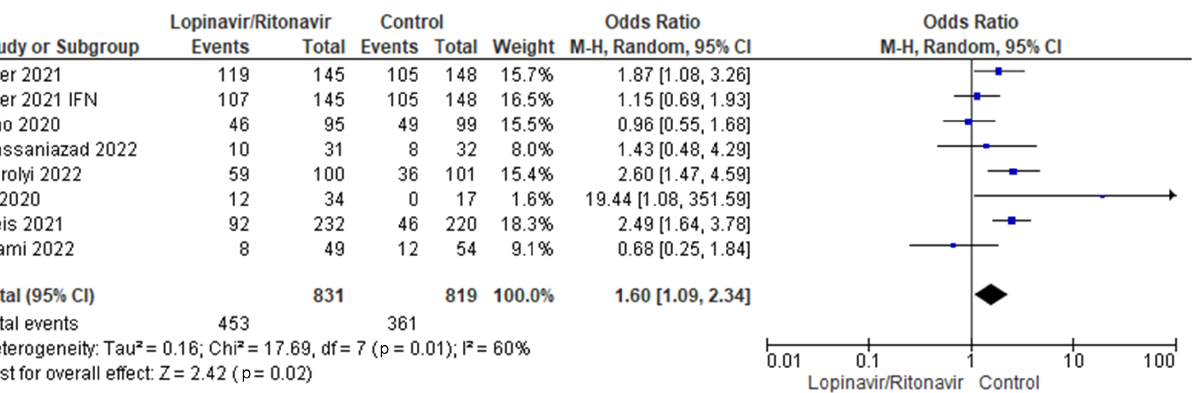
Figure 5. Forest plot analysis for length of hospital stay. The sizes of the green squares reflect the relative weight of the individual trials. The combined point estimate is shown as a black diamond. The diamond and squares (together with the 95% CIs) located beyond the vertical line (indicating the unit value) show that a result was statistically significant.